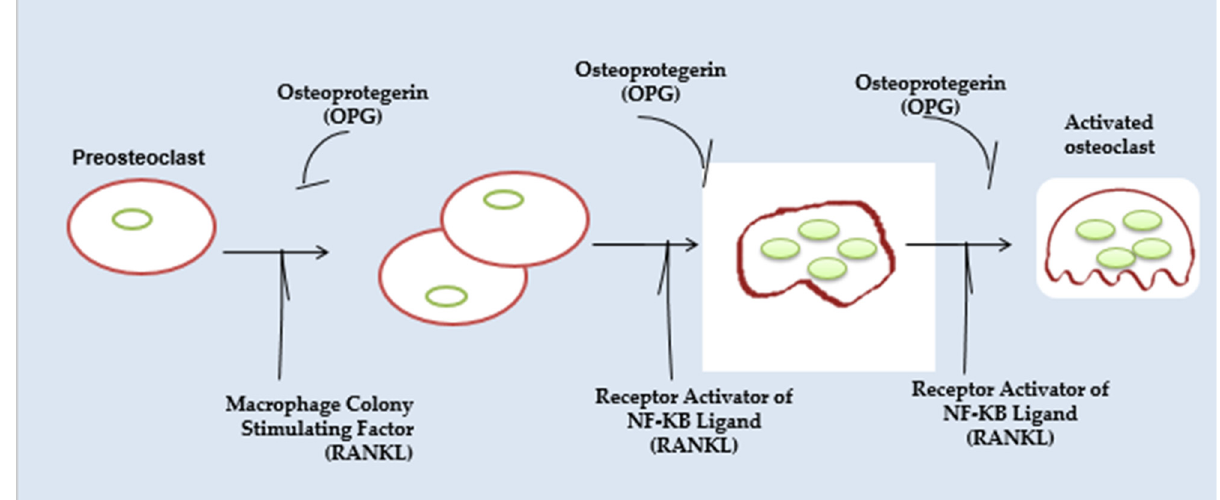
Figure 2. Multinucleated osteoclasts differentiating and becoming active.